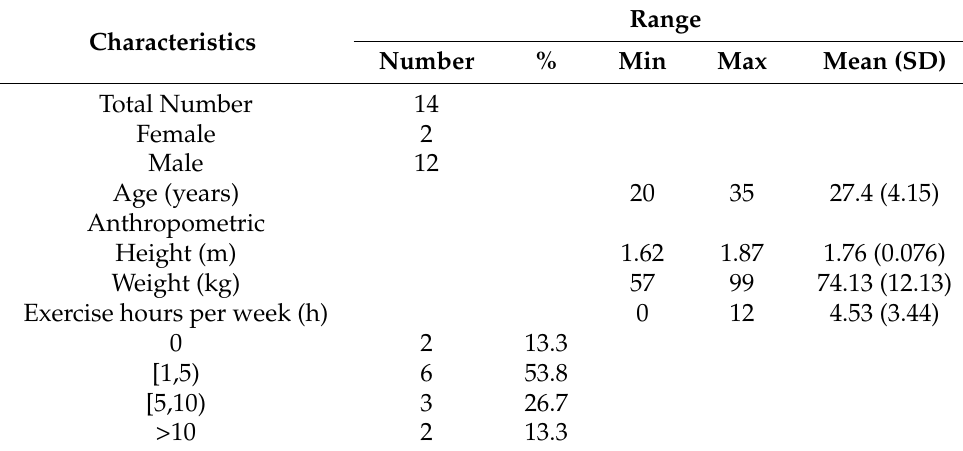
Table 1. Participants’ characteristics (SD: standard